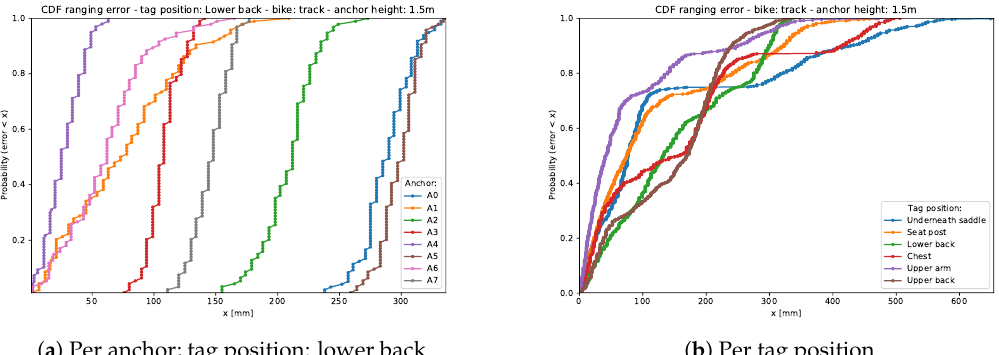
Figure 8. Example CDF ranging error; bike: track; anchor height: 1.5